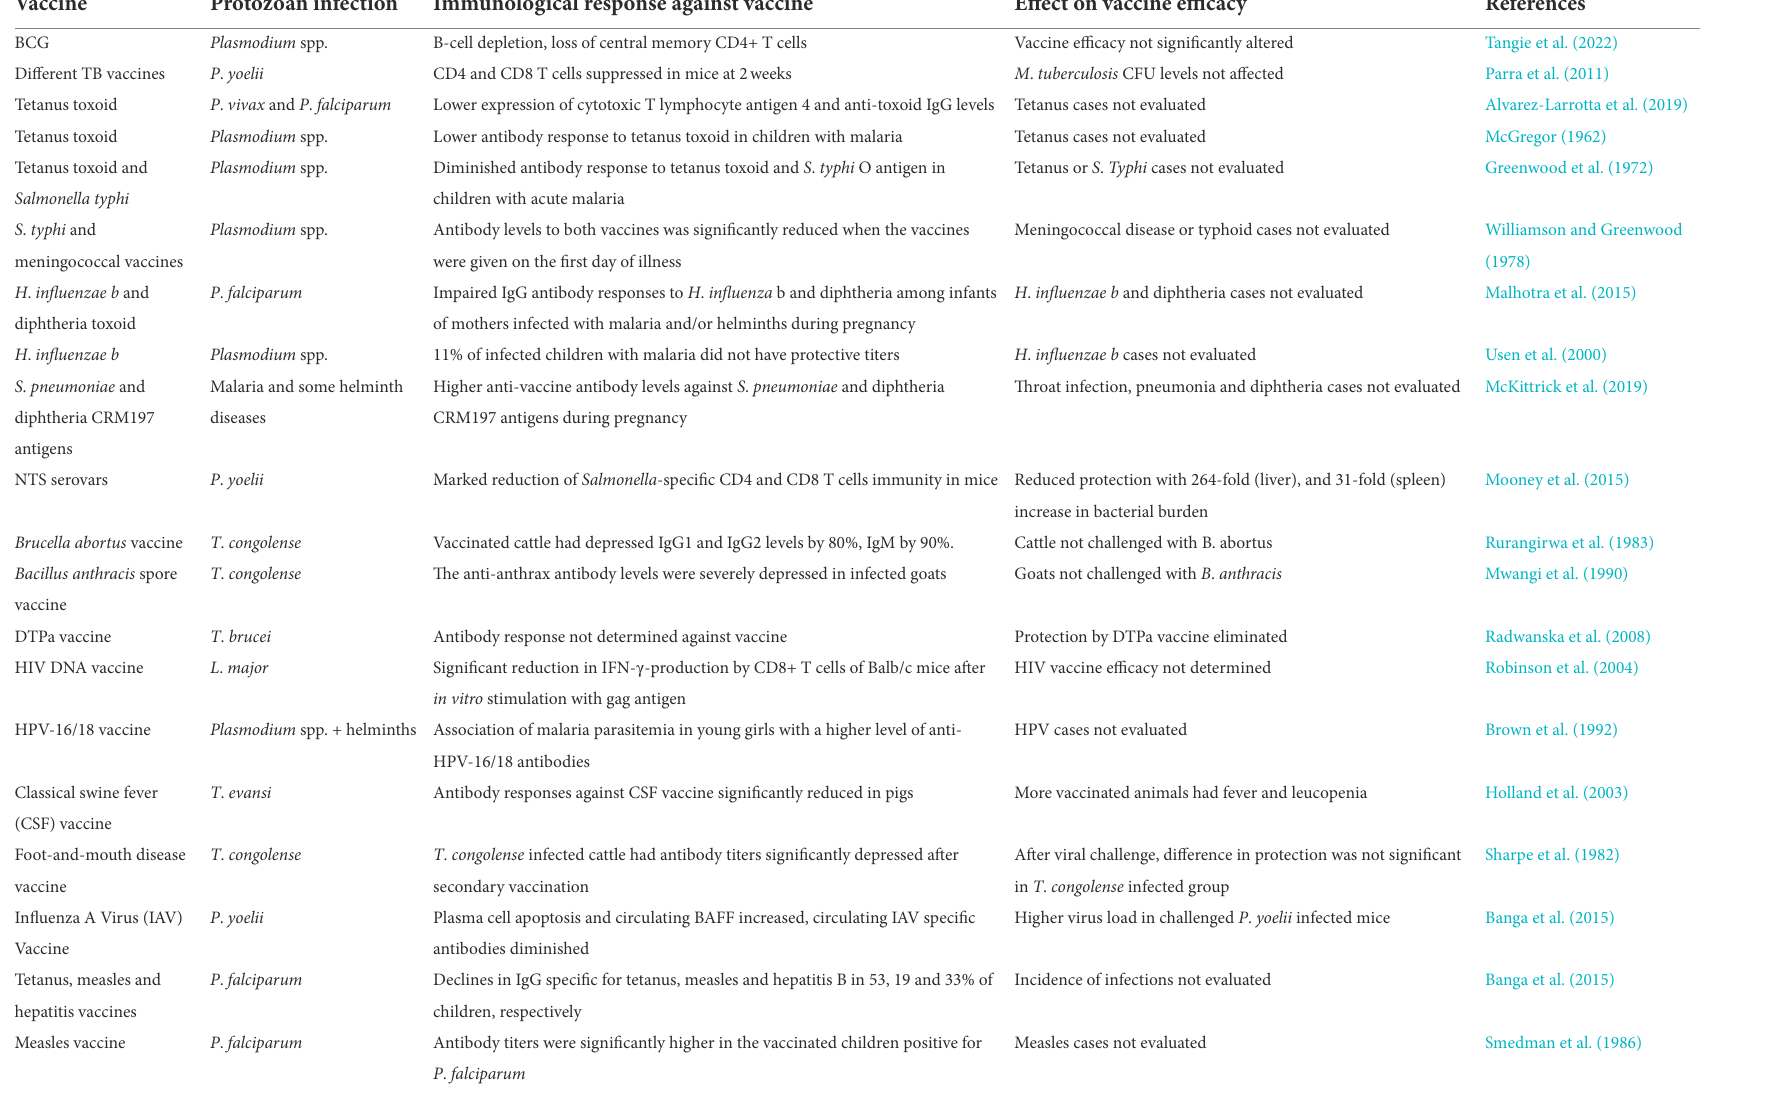
TABLE 1 The most common protozoa co-infections and its effects on bacterial/viral vaccines